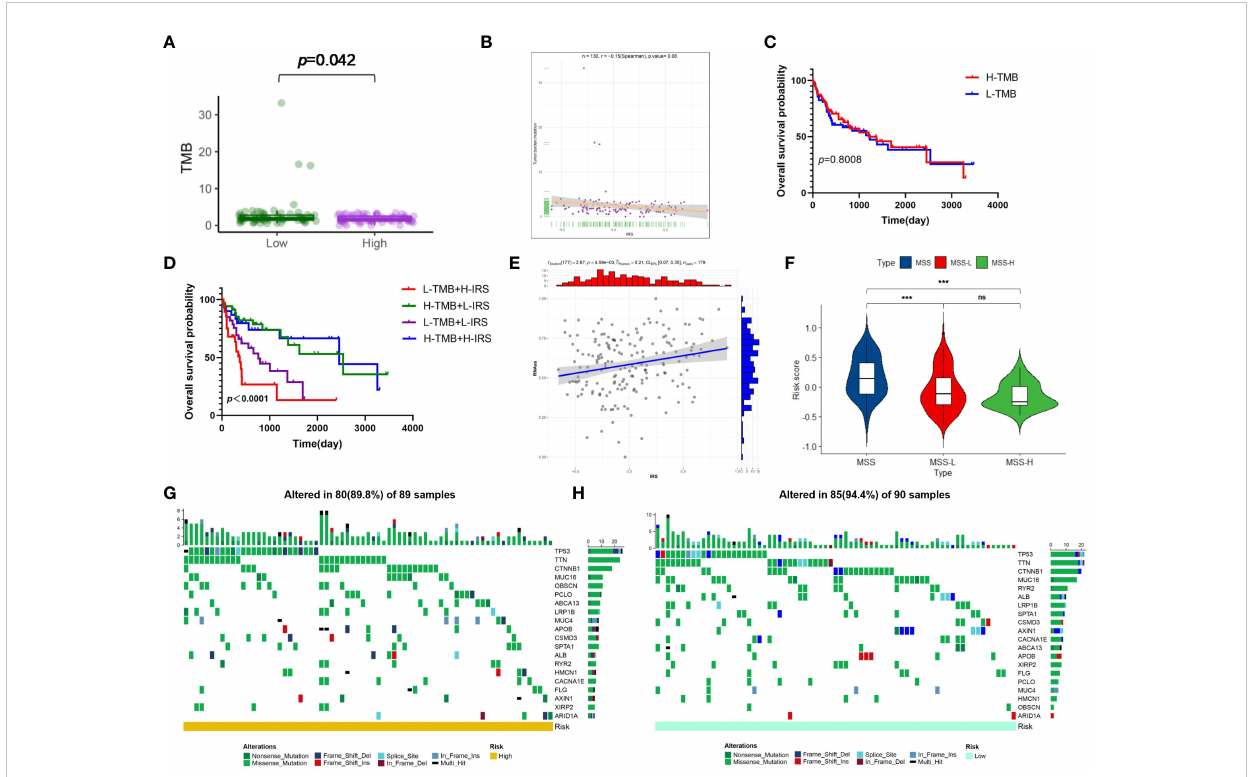
FIGURE 8 Risk signature-based tumor mutation burden (TMB), microsatellite instability (MSI), stemness analyses, and somatic mutation features. (A) The difference in TMB between the high- and low-risk groups. (B) Spearman ’ s correlation analyses between IRG and TMB. (C) Kaplan-Meier analysis of the OS between the low- and high-TMB groups. (D) The comparison of OS among four subgroups strati fi ed by both TMB and IRG score. (E) Correlation between IRG and mRNAsi scores (RNAss). (F) Relationships between IRG and MSI. The waterfall plot showing the differences in somatic genomic mutation between (G) the high- and (H) low-risk groups. *p < 0.05, **p < 0.01, ***p < 0.001, ns, not signi fi